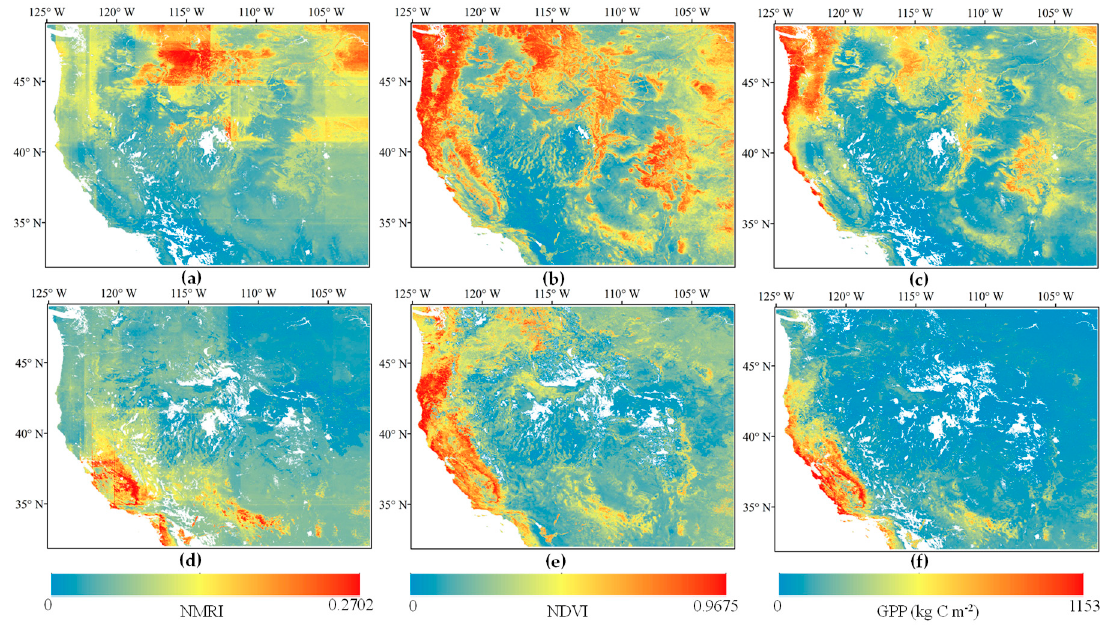
Figure 9. Point–surface fusion results of 500 m NMRI compared with NDVI and GPP: ( a ) NMRI-Summer; ( b ) NDVI-Summer; ( c ) GPP-Summer; ( d ) NMRI-Winter; ( e ) NDVI-Winter; ( f ) GPP-Winter.